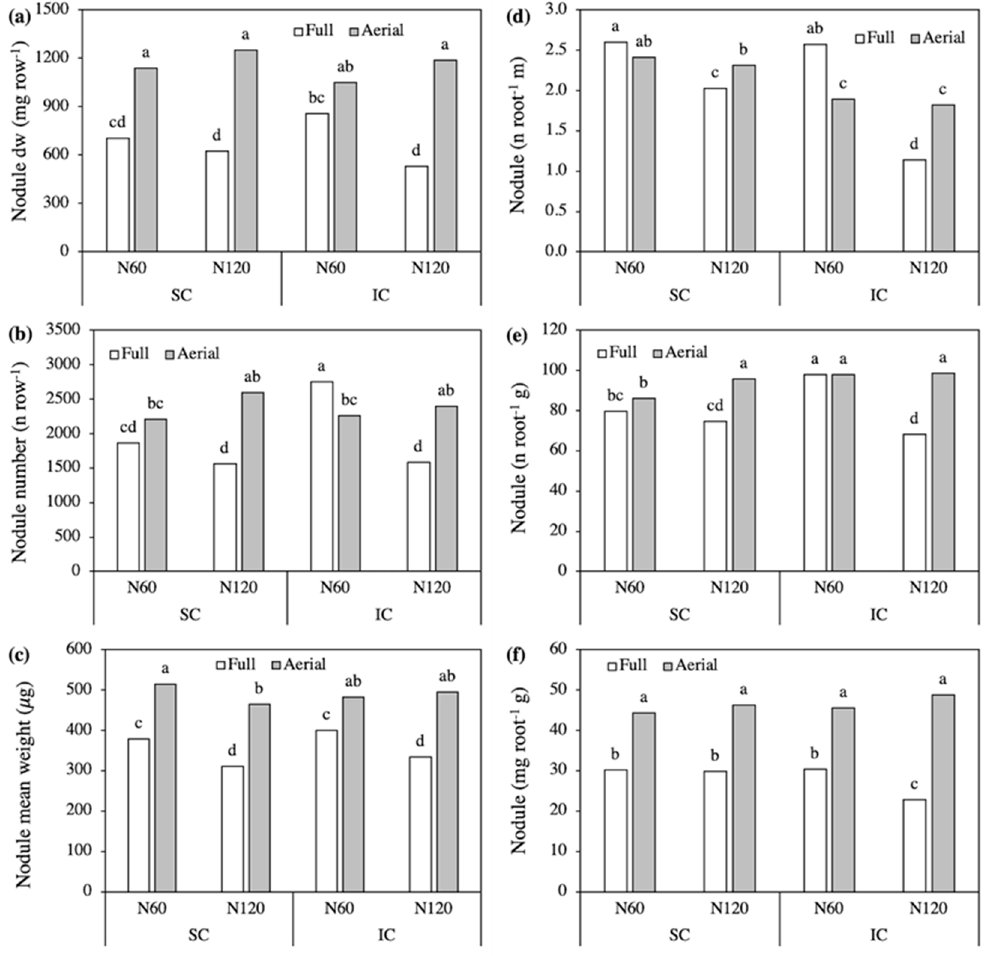
Figure 3. Nodule parameters ( a , b , c ) and nodule:root ratios ( d , e , f ) as affected by the Crop system × N level × Row contact interaction. SC, sole crop; IC, intercrop. Values are the mean of three replicates. In each figure, bars with different letters indicate that the corresponding means are significantly different at P < 0.05, Tukey’s test.